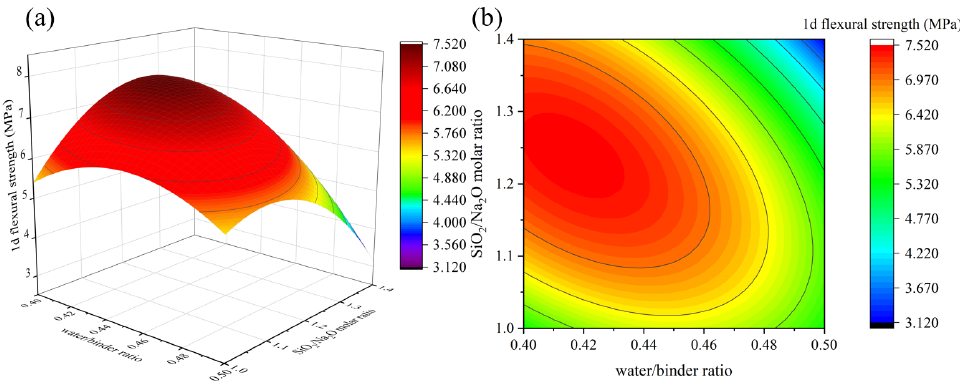
Figure 11 . The interaction effect of water/binder ratio and GGBS content on 1 d flexural strength: ( a ) 3D response surface; ( b ) contour diagram.